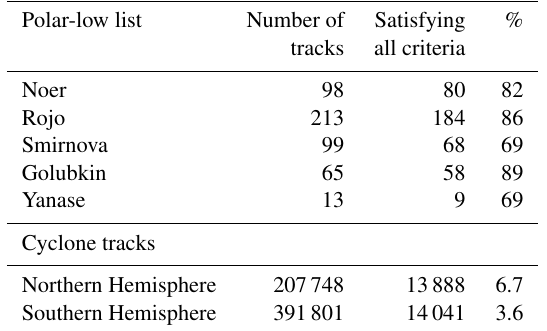
Table 3. Statistics for the satisfaction of the polar-low criteria from the polar-low lists and all cyclone tracks of the two hemispheres for the years